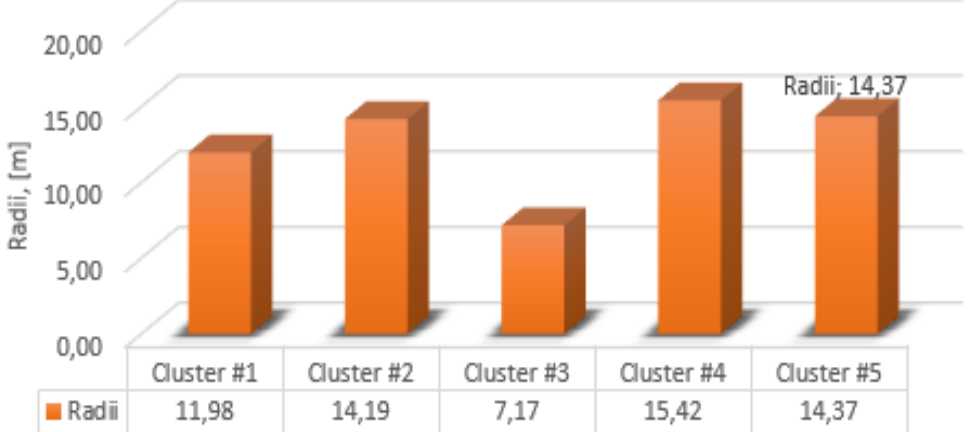
Figure 11. Radii of clusters.